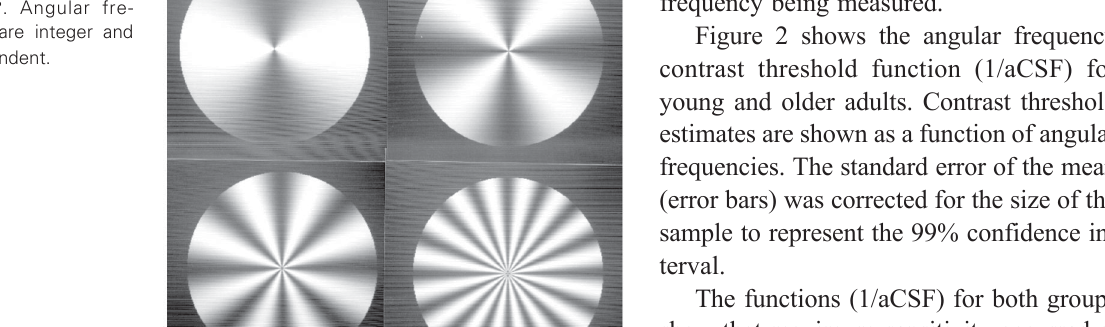
Figure 1. Examples of angular frequency stimuli at 2, 4, 8 and 16 cycles/360 º . Angular fre- quency stimuli are integer and distance